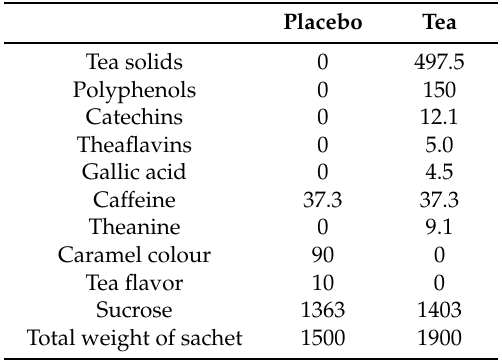
Table 1. Composition of the test products (mg per